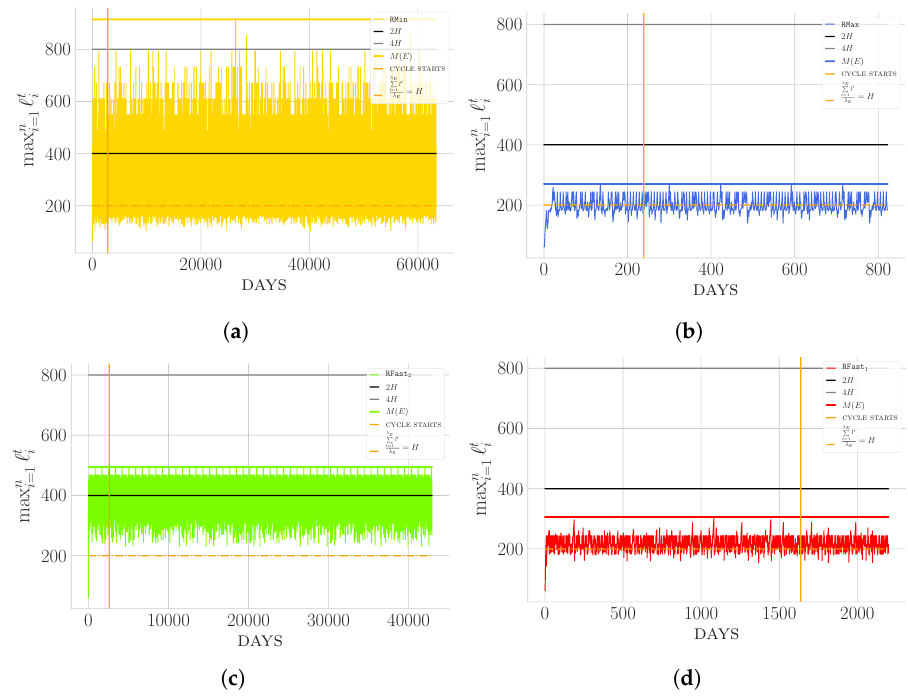
Figure 12. Snapshot of the evolution of maximum heights when strategies: RMin ( a ); RMax ( b ); RFast 2 ( c ); and RFast 1 ( d ) are applied on an instance having n = 10 and H = 200 (in details, structured as follows [ 61;30;27;26;13;11;10;10;9;3 ] ). Data are plotted as in Figure